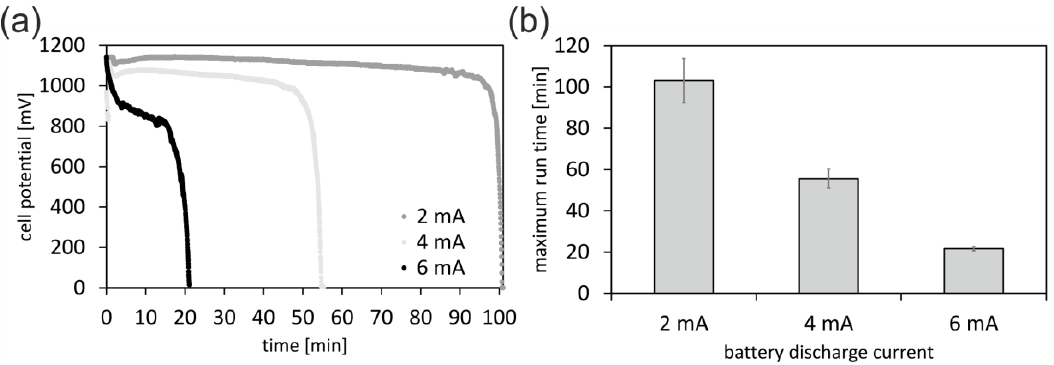
Figure 2. Battery performance analysis. ( a ) The discharge behavior of the battery was tested at discharge currents of 2 mA, 4 mA, and 6 mA. At lower discharge currents, the cell potential remains largely constant and only drops dramatically when the electrolyte is completely consumed. ( b ) At discharge currents of 2 mA, 4 mA, and 6 mA, the battery operates for an average of 100 min, 60 min, and 20 min, respectively.